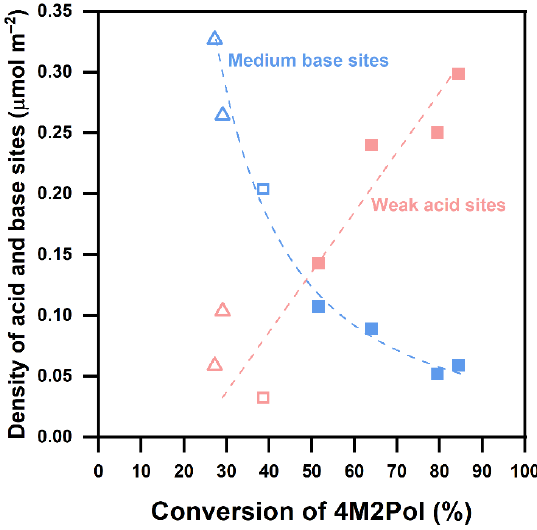
Figure 7. Correlation of 4M2Pol conversion with the surface density of weak acid sites and medium base sites for x YSZ (filled squares), x Y/ t -ZrO 2 (open triangles), and bare t -ZrO 2 (open squares).